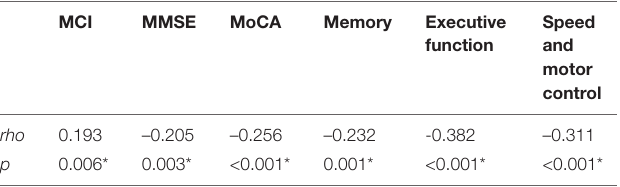
TABLE 5 | Spearman correlation analysis of total CSVD burden and cognitive function after propensity score matching. MCI